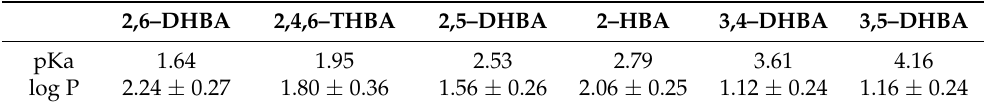
Figure 5. Reference potential obtained by surface modification with six types of HBAs. The error bar expresses the SD, of the data, of n = 4 (electrode) × 4 (rotation) = 16 values. Table 3. The pKa and log P of HBAs.